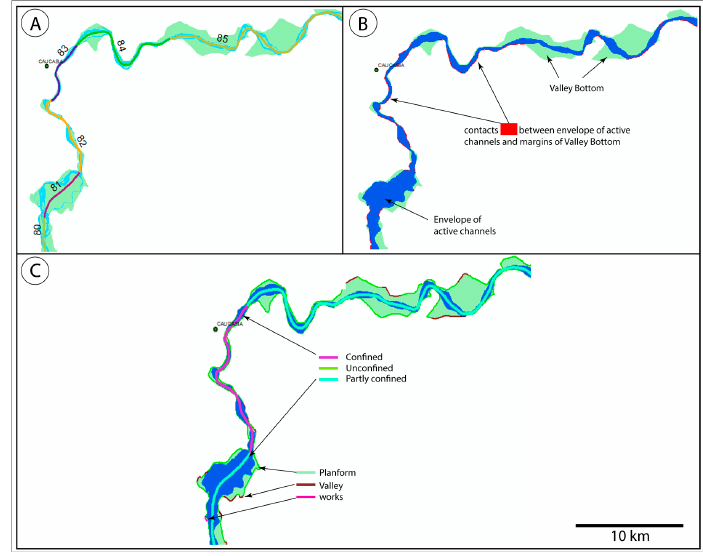
Figure A2. Example of output for a stretch of the Cauca River from the proposed confinement algorithm: A) active channel (narrow, light blue polygon), VB (light green polygon) and reaches (identified by colors of the axis segments); B) identification of contacts (small red segments or dots); C) confinement categorical indicator and types of margins of the VB. Notice that several contiguous reaches have the same confinement classification (e.g., 80, 81, bottom left in A, are partly confined; 82, 83 confined), but different type of Cause of confinement (because of different type of VB margin) and hence are displayed in a different color.